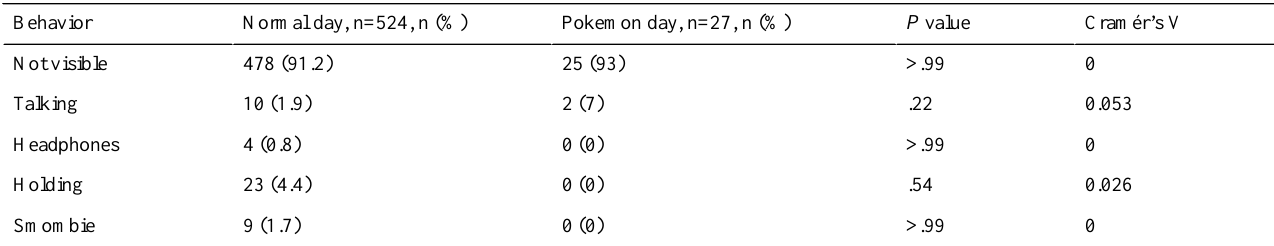
Table 14. Influence of the Pokemon Go Community Day on the smartphone usage behavior in older people (globally P =.25,